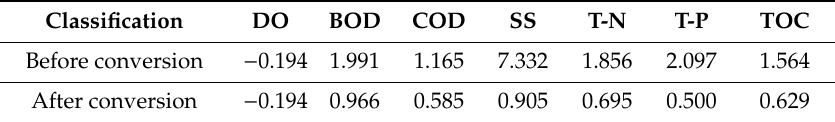
Table 9. Variation in the skewness of water quality data based on the normality